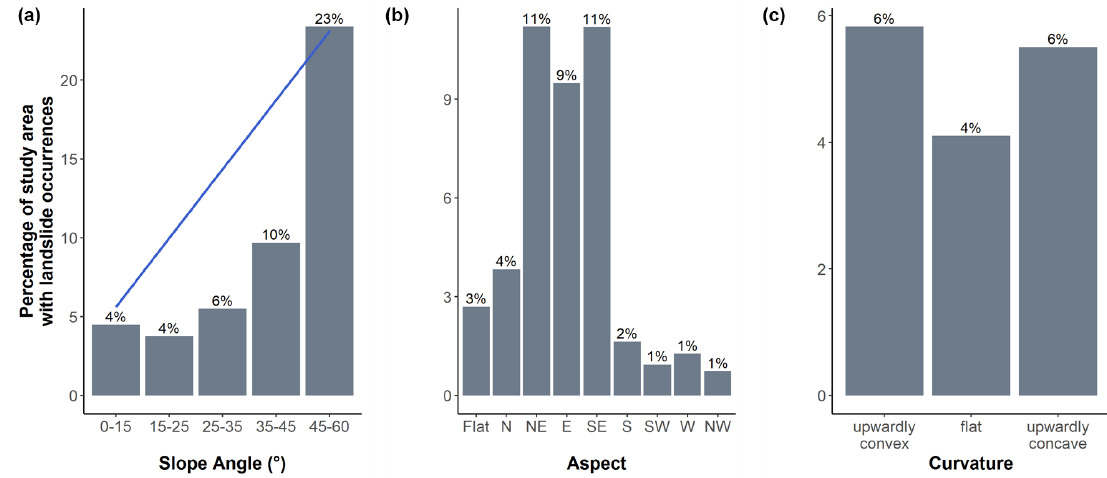
Figure 7. Percentage of the landslide area in relation to the total study area, in each classification of (a) slope (blue trend line), (b) aspect, and (c)